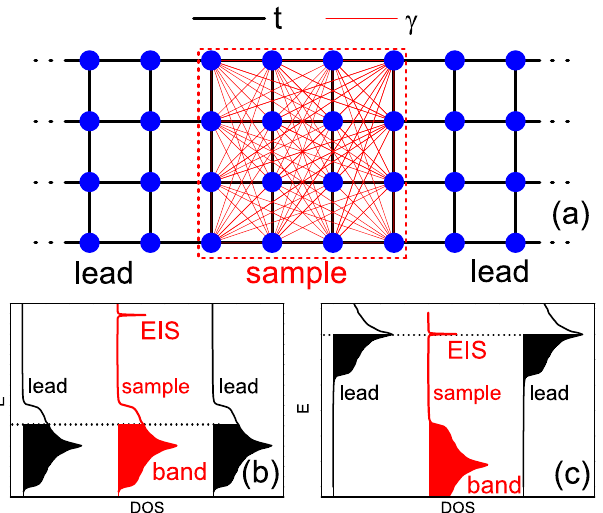
Figure 1. (Color online) Illustration of transport setups in our simulation. ( a ) Two-terminal conductance setup, where a 4 × 4 sample (encircled by the red dashed-line square) with long range hopping is connected to two leads with short range hopping. Black (red) bonds represent the nearest (long range) hopping t ( γ ). ( b ) and ( c ) illustrate the energy band configurations among the sample (red) and leads (black) used in Sections III and IV, respectively, where the black dashed line labels the chemical potential. Created from OriginPro 8 SR0 (URL:http:// www. Origi nLab.